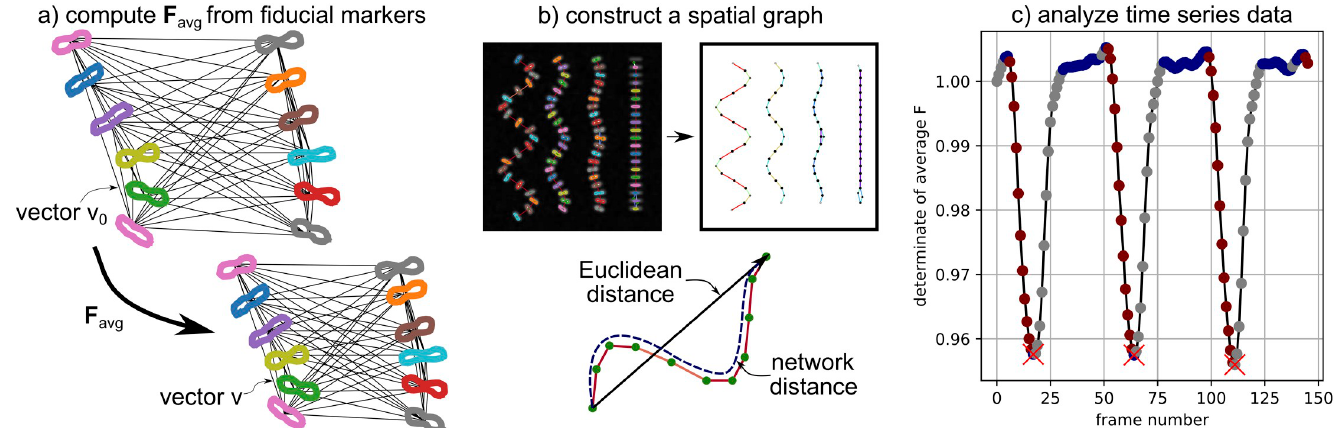
Fig 4. Data analysis from segmentation and tracking: (a) Tracked elements are treated as fiducial markers and used to construct an average deformation gradient F (see Eqs 1–4); (b) z-discs and sarcomeres are tracked independently and used to construct a spatial graph (z-discs are “nodes” and sarcomeres are “edges”, edge color corresponds to sarcomere orientation, node color corresponds to correlation in sarcomere orientation) to measure correlations based on network distance; (c) Automated analysis of time series data is used to extract constants such as mean contraction time and number of peaks.